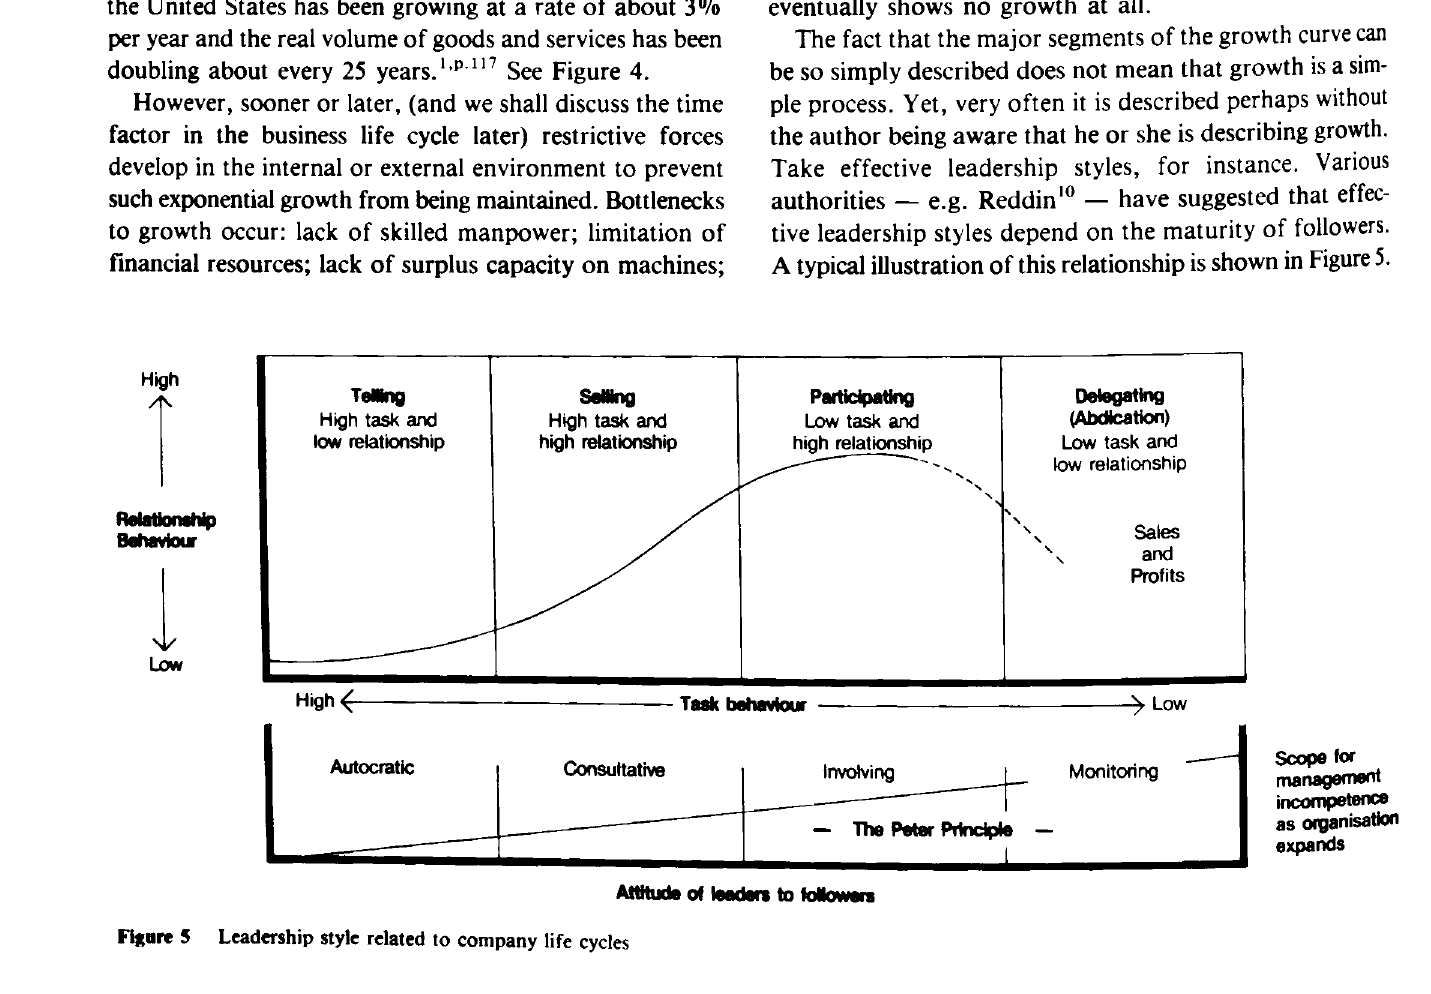
• Seasonally adjusted annual rates. 1Trend line of 3,5% from middle of 1955 to 1962 IV; 3,75% from 1962 IV to 11185 IV; 4% from 1965 IV to 1969 IV; 4,3% from 1969 IV to 1970 IV; 4,4% from 1970 IV to 1971 IV; and 4.3% from 1971 IV to 1975 IV. Sources: Department of Commerce and Council of Economic Advisers. Figure 4 Growth rate of goods and services in the US (Reproduced from Robert Dorfman, Prices and Markets, 2nd ed., Prentice-Hall, Enge)wood Cliffs, 1972,